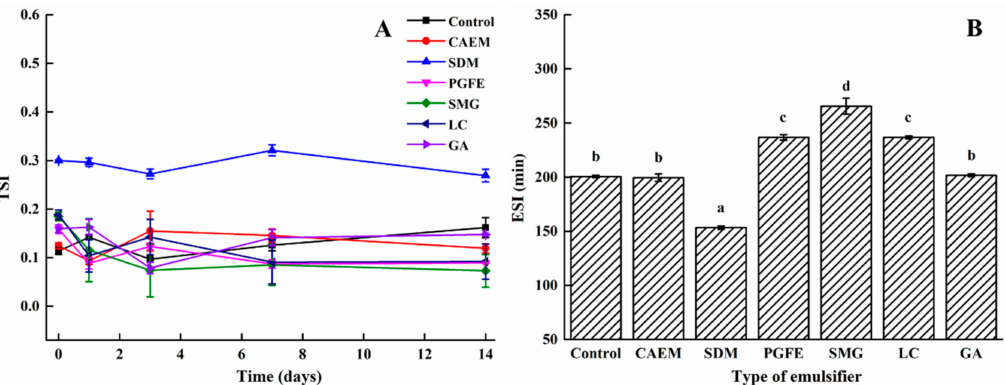
Figure 8. Turbiscan stability index (TSI) ( A ) and emulsifying stability index (ESI) ( B ) values of emulsions prepared with di ff erent